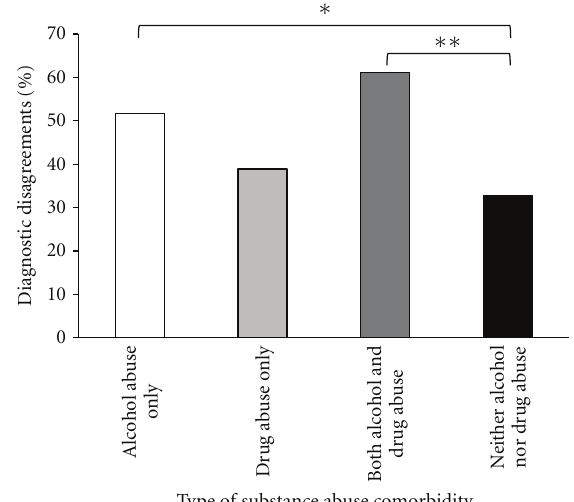
Figure 1: Percentage of diagnostic disagreements between the “pregold standard” diagnosis and the “gold standard” diagnosis by the type of substance abuse that was present. ∗ P < 0 . 10, ∗∗ P < 0 . 05.